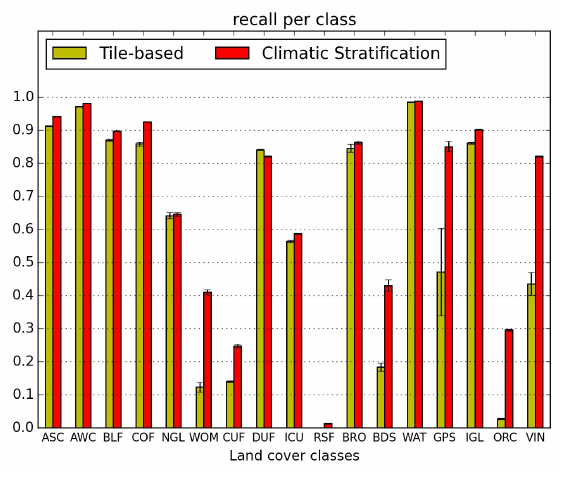
Figure 15. Recall per class.